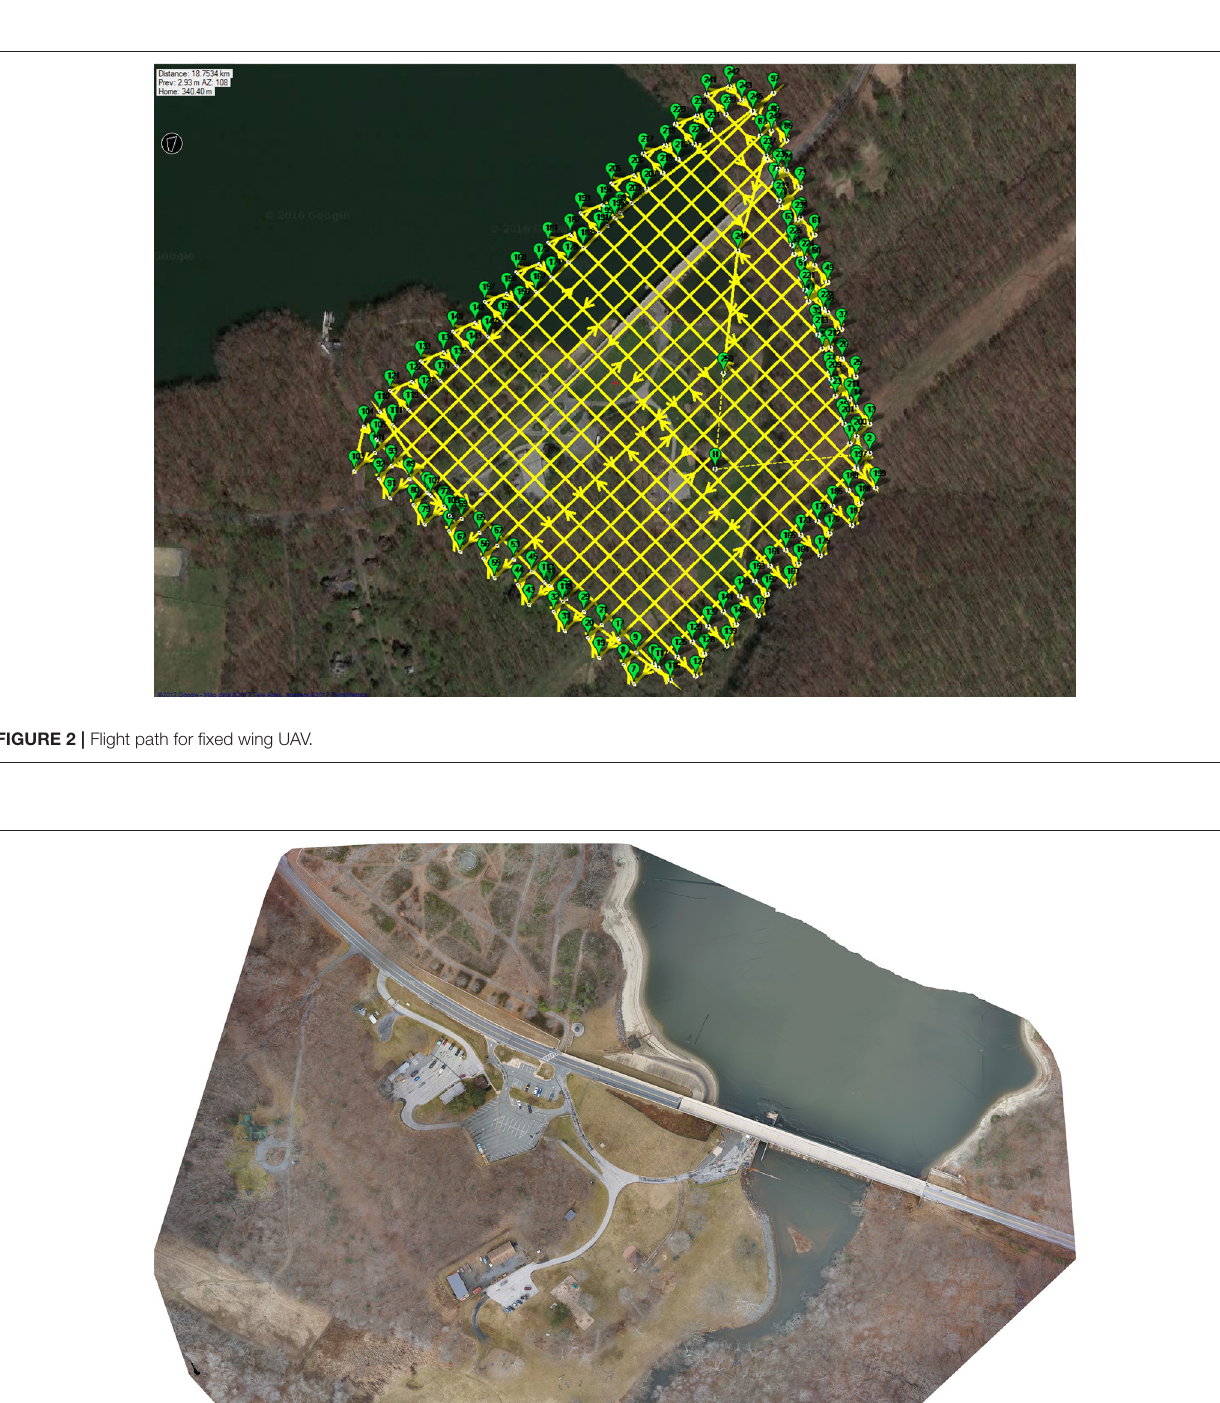
Frontiers in Built Environment |